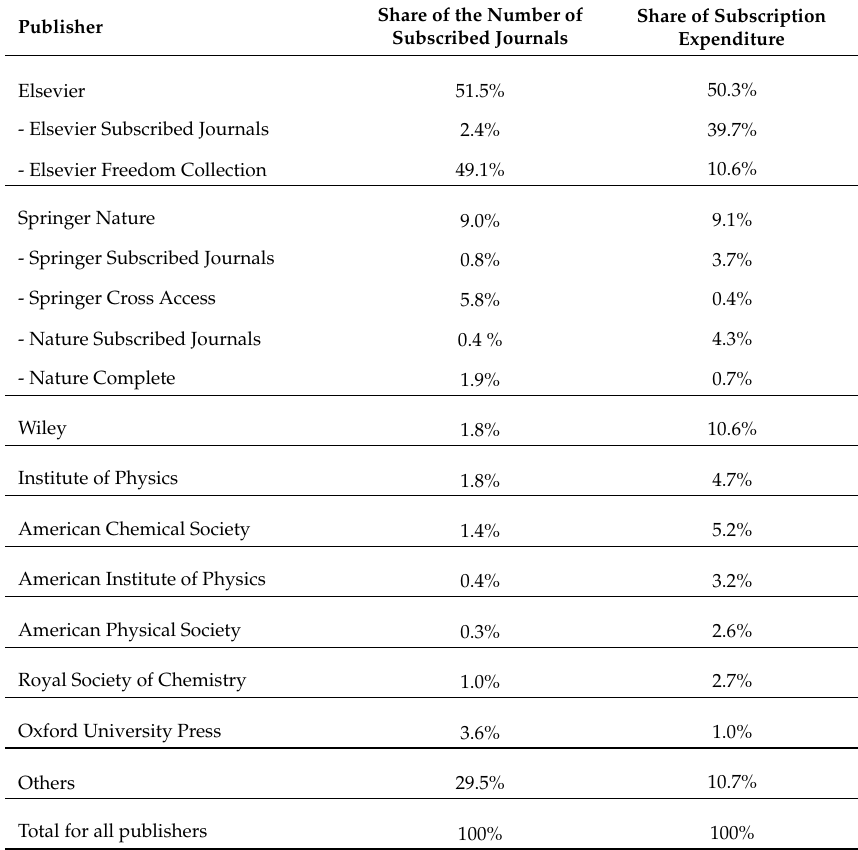
Table 1. Shares of the number of subscribed journals and of subscription expenditure.